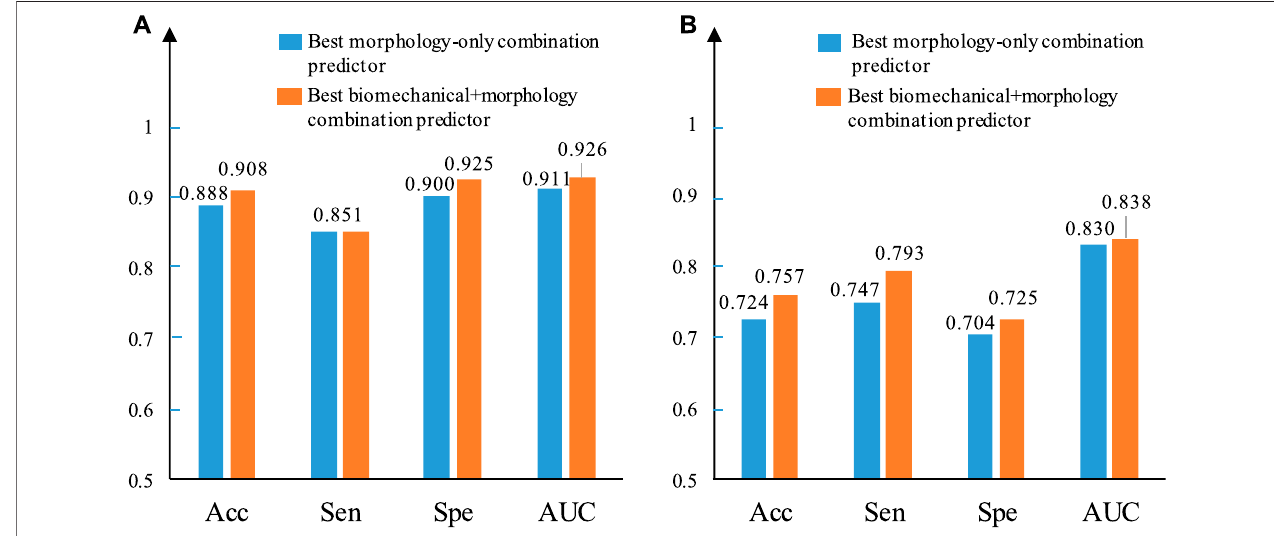
FIGURE 6 | Comparison between the best morphology – only combined predictor and the best biomechanical + morphology combined predictor using IO data based on Δ MinCapT prediction results. (A) IO prediction result based on GLMM. (B) IO prediction result based on LSSVM. AUC: area under the ROC curve; Acc: accuracy; Sen: sensitivity; Spe: speci fi